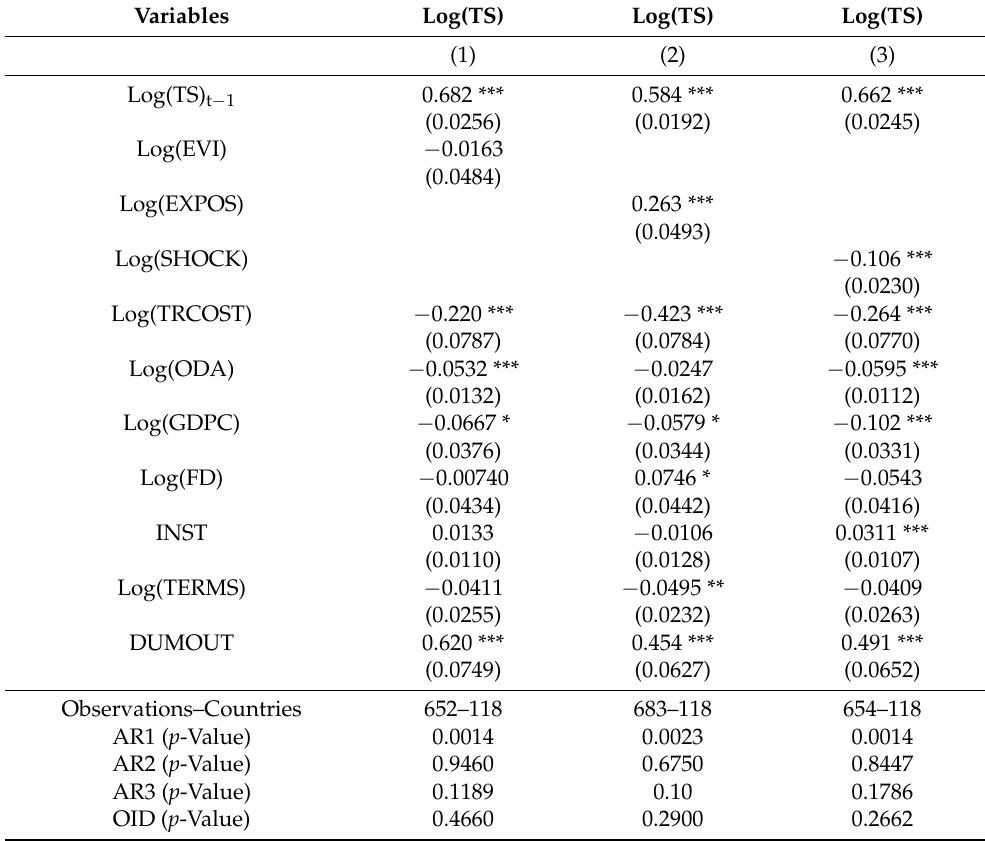
Table 2. Robustness check on the effect of EVI on participation in international trade. Estimator : Two-step system